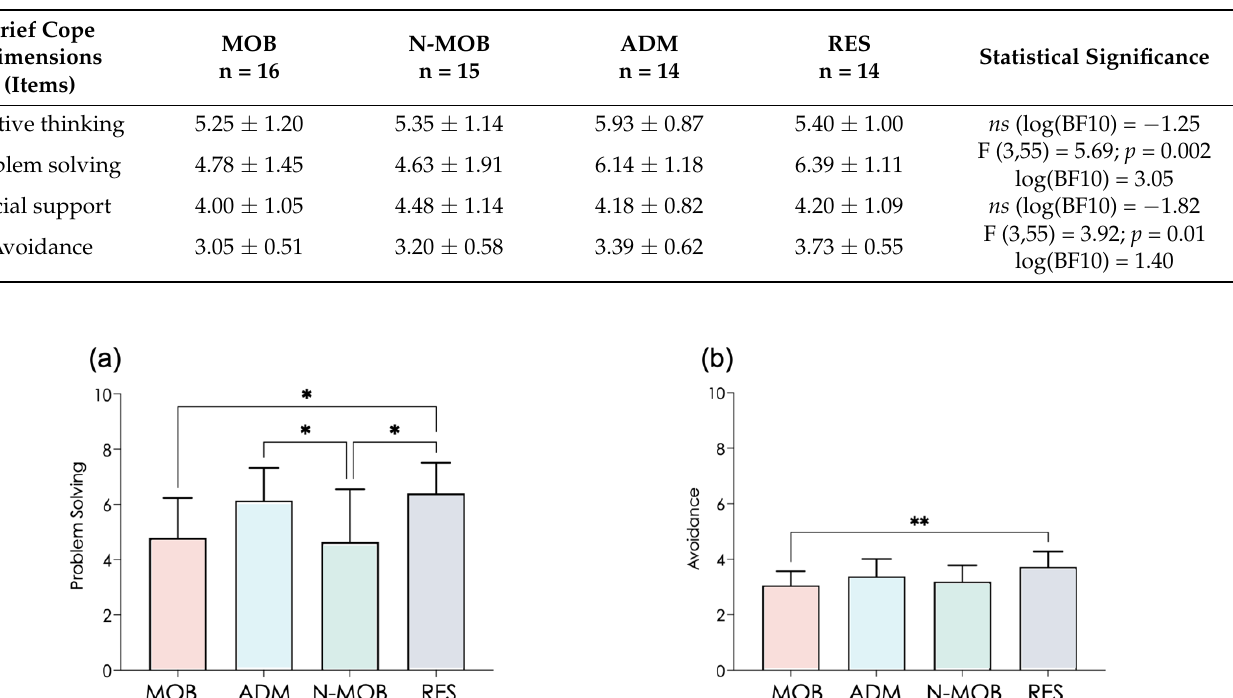
Table 2. Means and standard deviations of the Brief-COPE subscales according to the type of emotional situation.